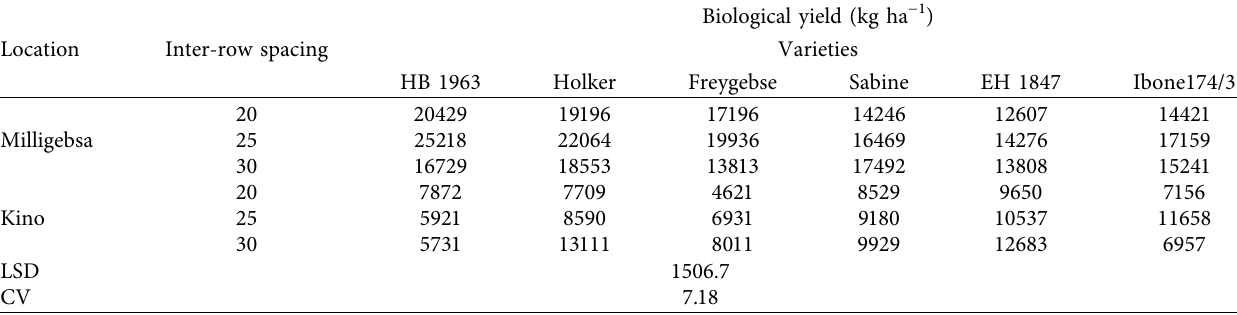
Table 7: Interaction effect of varieties, inter-row spacing, and location on biological yield of malt barley at Debark, north Gondar, Ethiopia, in 2019.